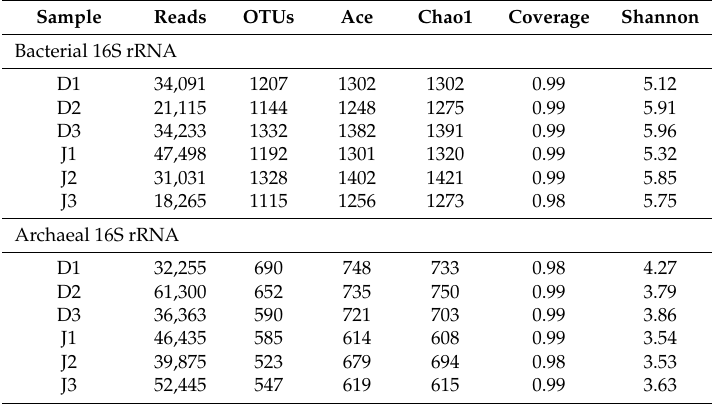
Table 6. Diversity indices of bacteria and archaea of the two